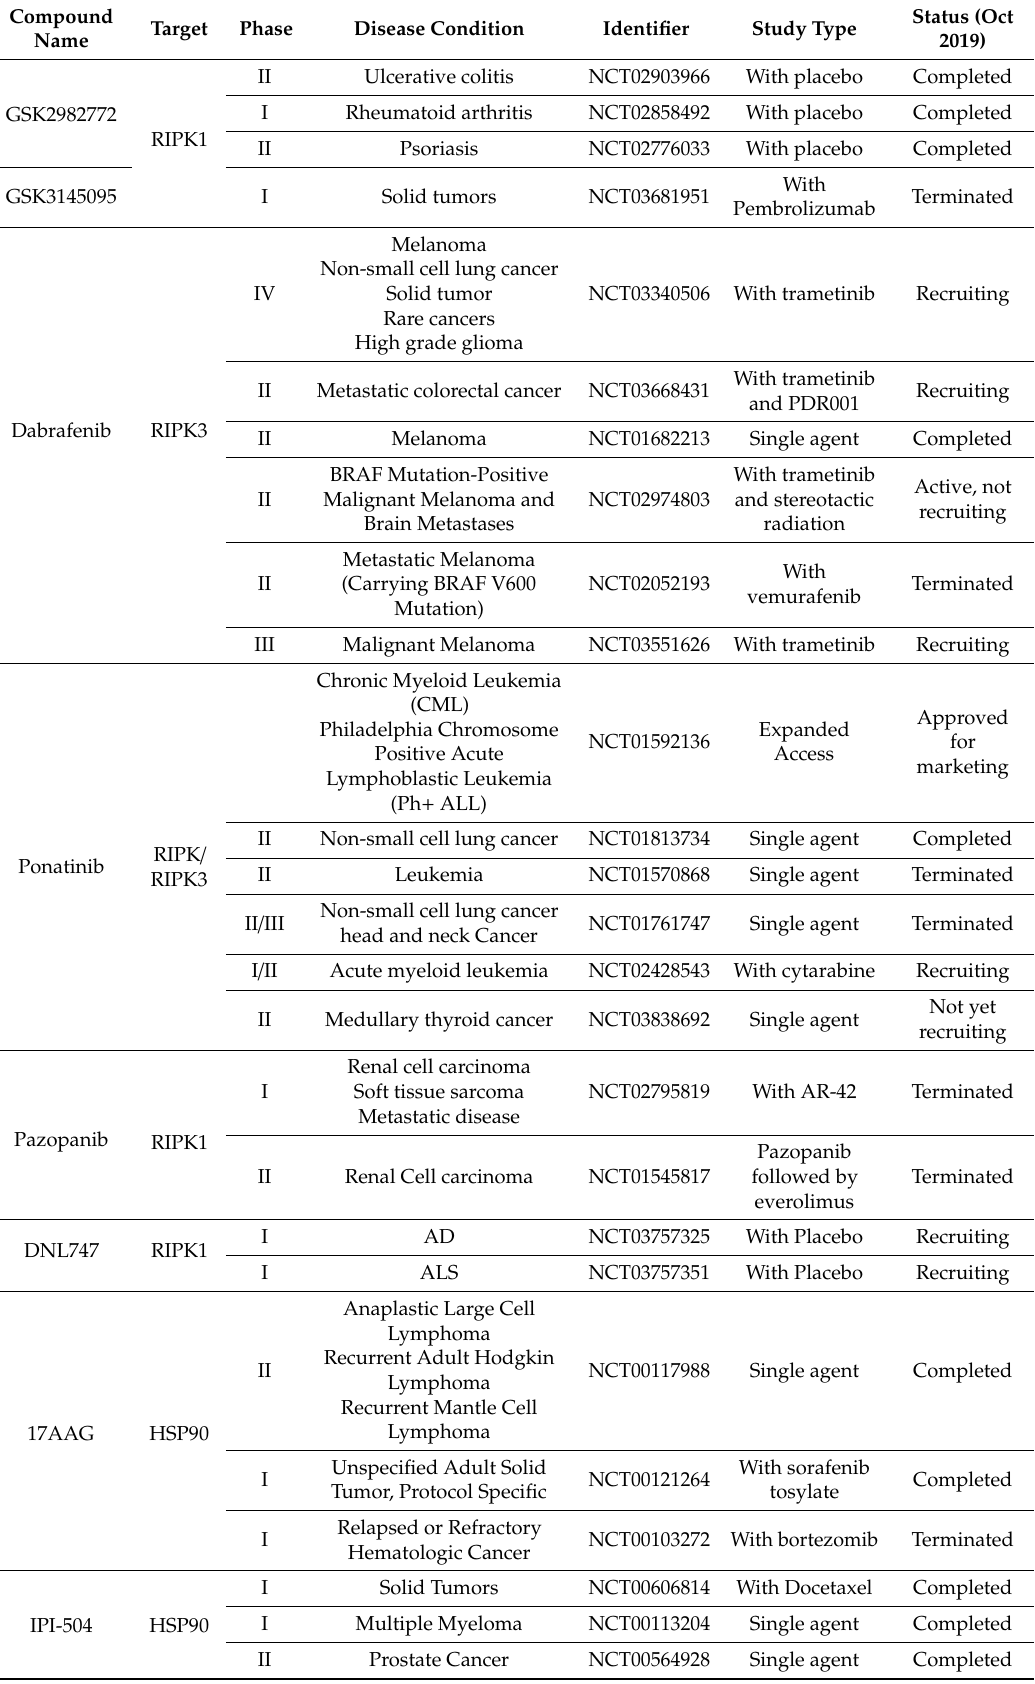
Table 3. Necroptosis inhibitors under clinical